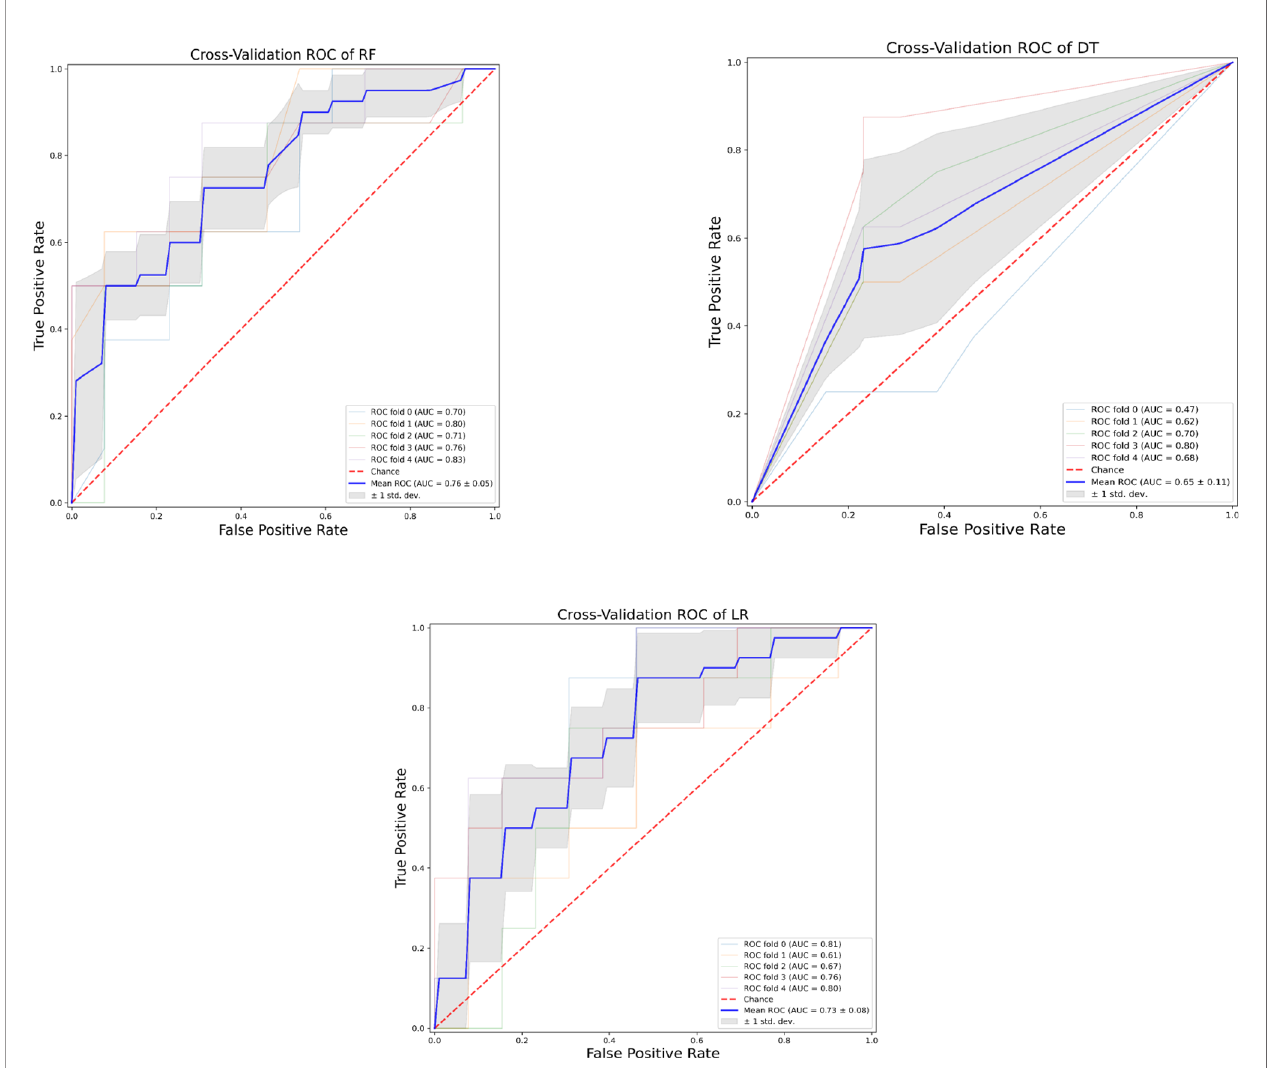
FIGURE 2 | Receiver operating characteristic curves of the assessed algorithms. AUROC, Area under the receiver operating characteristic curve; DT, Decision tree; LR, Logistic Regression; RF, Random Forest.